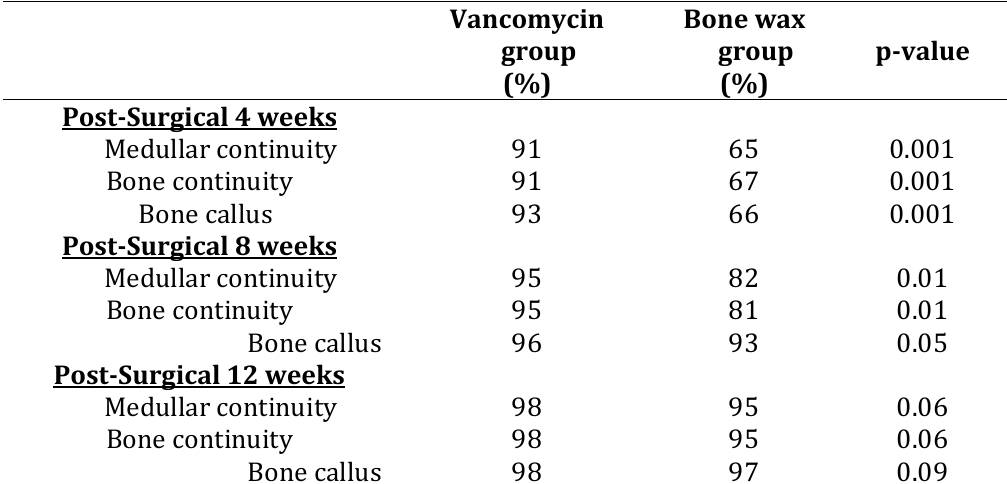
by Computed Axial